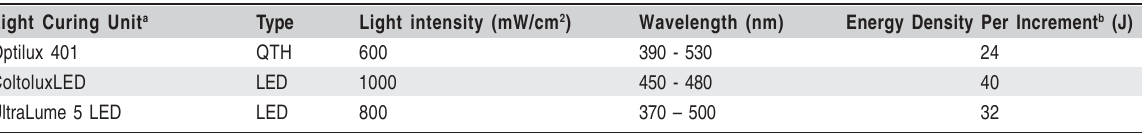
Table 1 – Light-curing units used in the